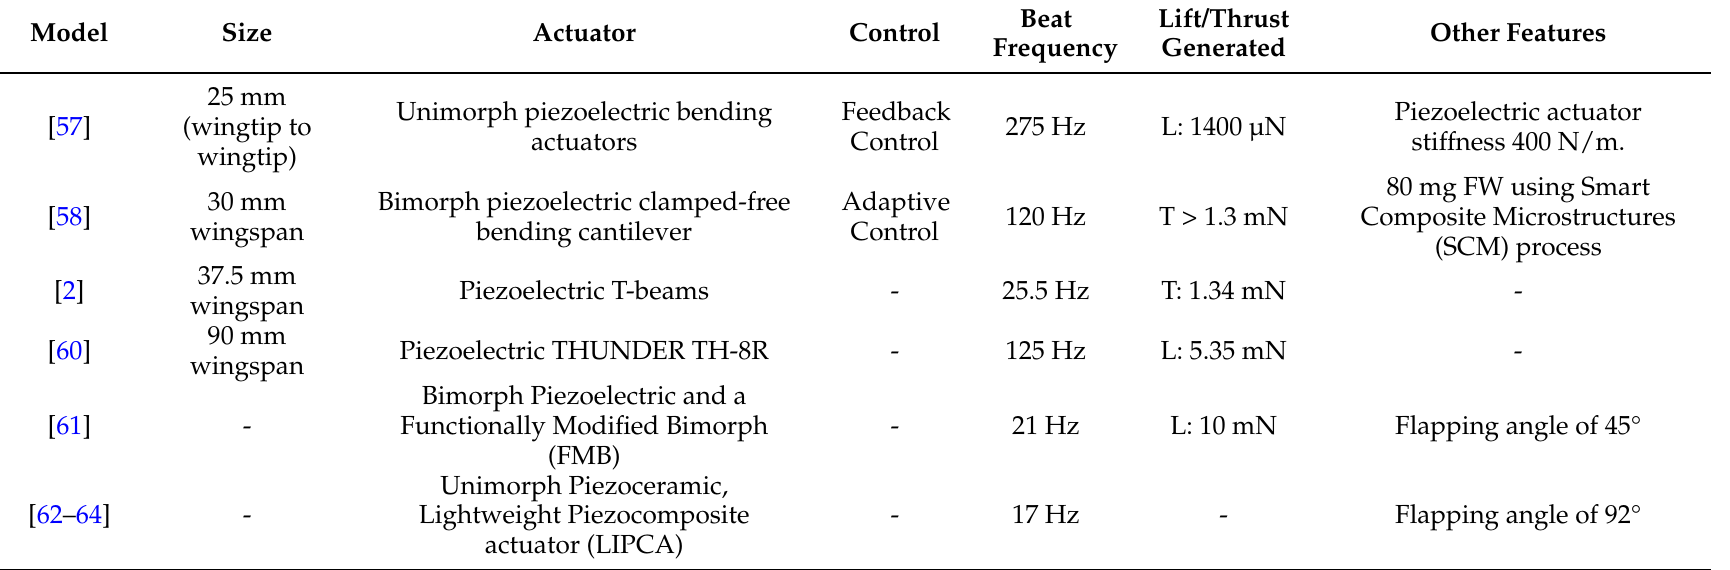
Table 1. List of main characteristics between the different prototypes of Micro Aerial Vehicles (MAVs) and Nano Air Vehicles